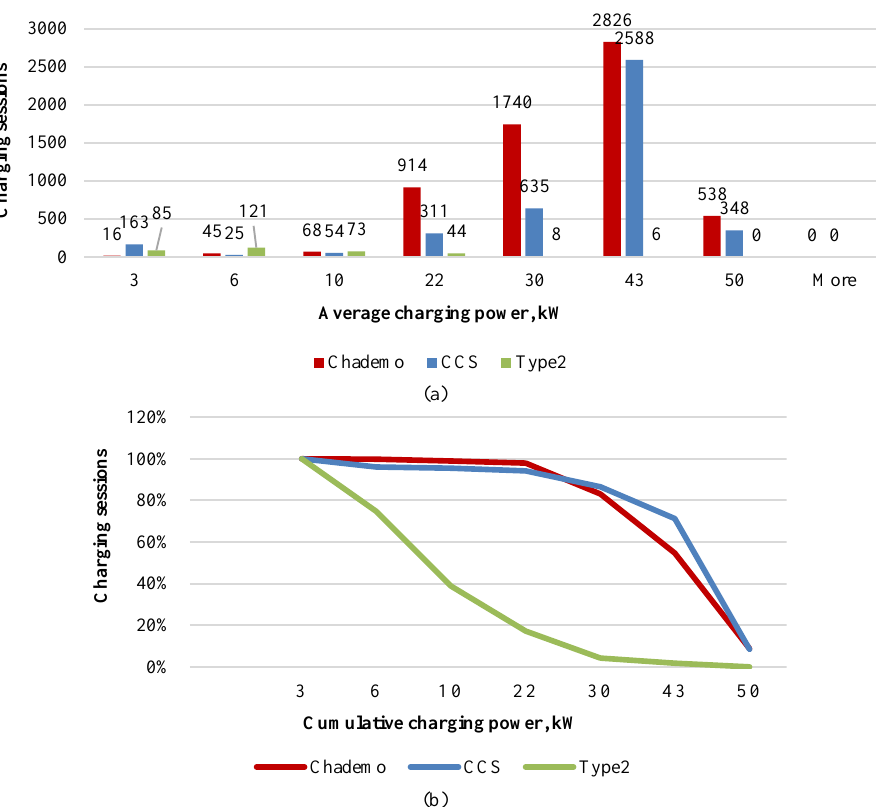
Fig. 3. (a) Charging power sessions depending on the type of connector, 2018; (b) charging power cumulative distribution depending on the type of